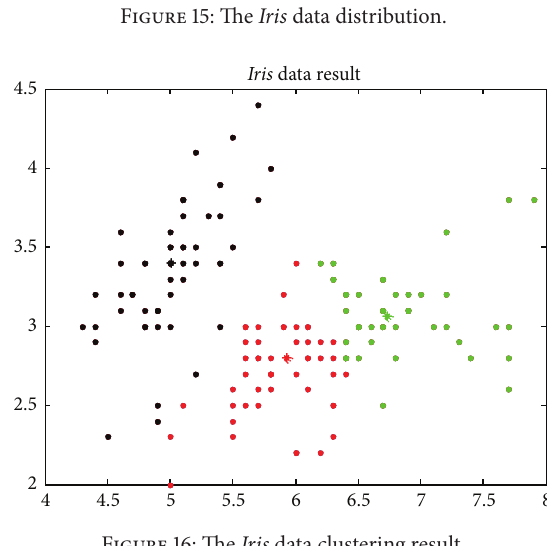
Figure 15: The Iris data distribution.